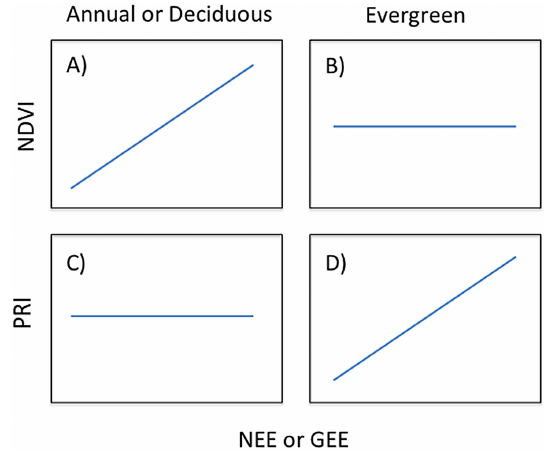
Figure 8. Hypothesized relationships between NDVI ( a and b ) and PRI ( c and d ) and daily NEE or GEE for annual or deciduous (left) or evergreen (right) vegetation. In this example, more positive val- ues indicate greater photosynthetic carbon uptake. Modified from Garbulsky et al.